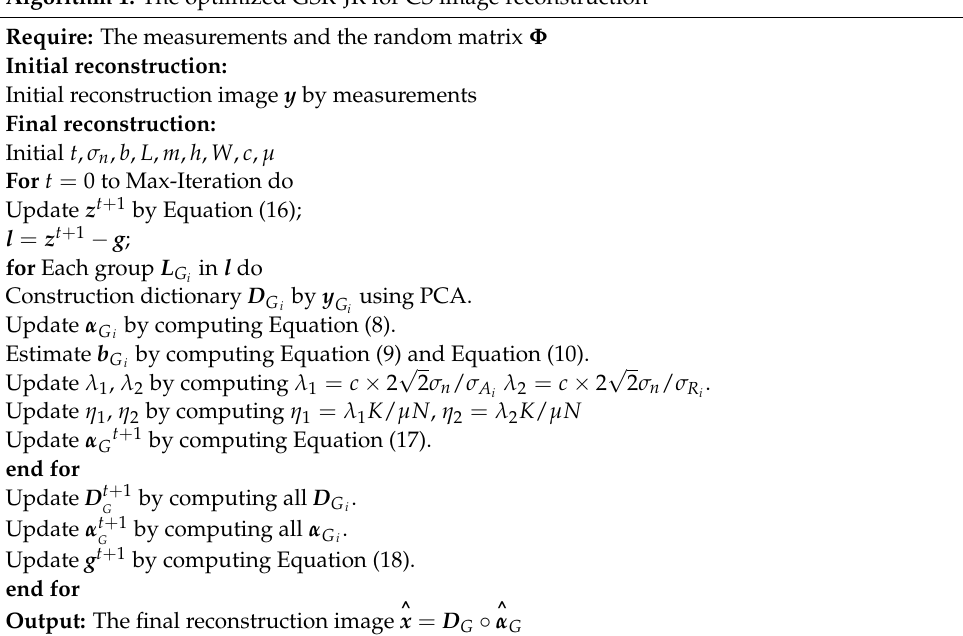
Algorithm 1: The optimized GSR-JR for CS image